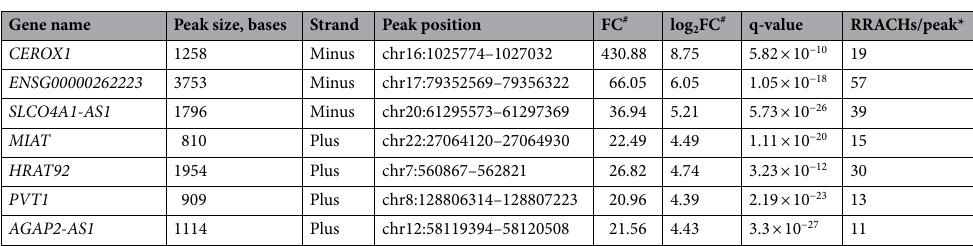
Table 1. The detailed information of selected GSCs specific m6A peaks in lncRNAs. # FC – fold change of m6A peak signal in NCH421K as compared to U87-MG cell line. *Number of RRACH motifs per single